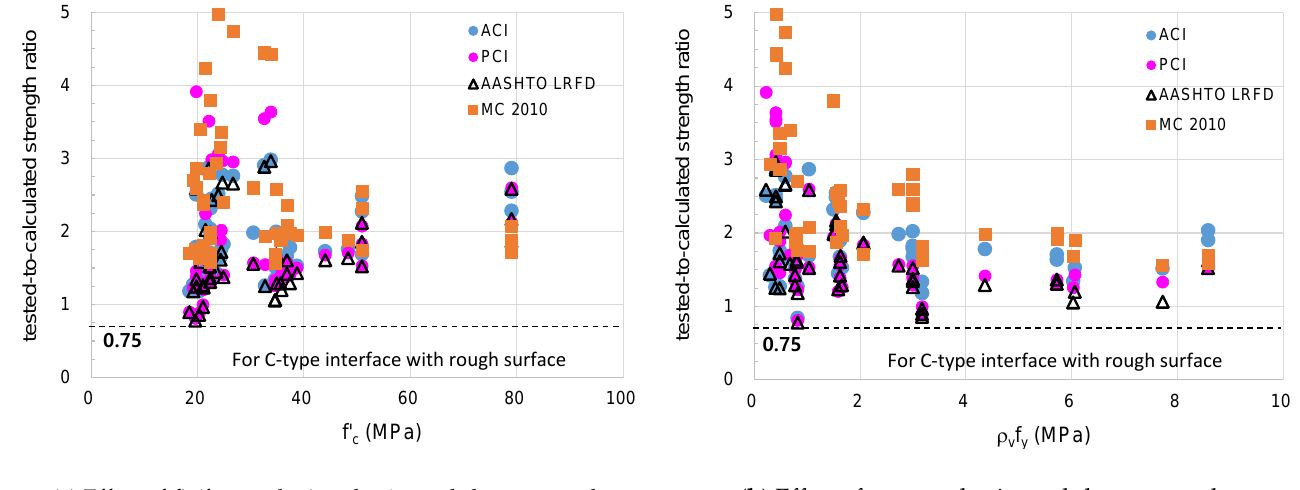
Figure 13. C-type interface for beam specimens with roughened surface.